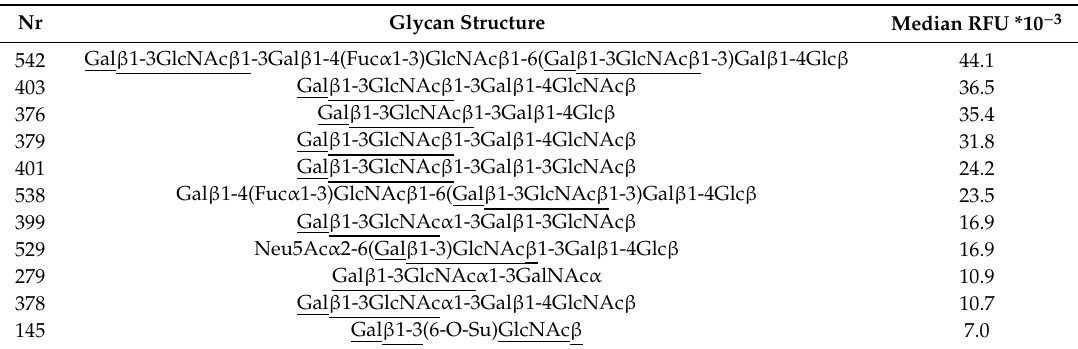
Table 1. Specificity of mice antibodies (IgG + IgM + IgA) isolated with Le C -Sepharose, printed glycan array (PGA) data. The outmost and branch-type Le C motifs are underlined; the innermost ones are shown in grey. Fm, formyl group, that is,